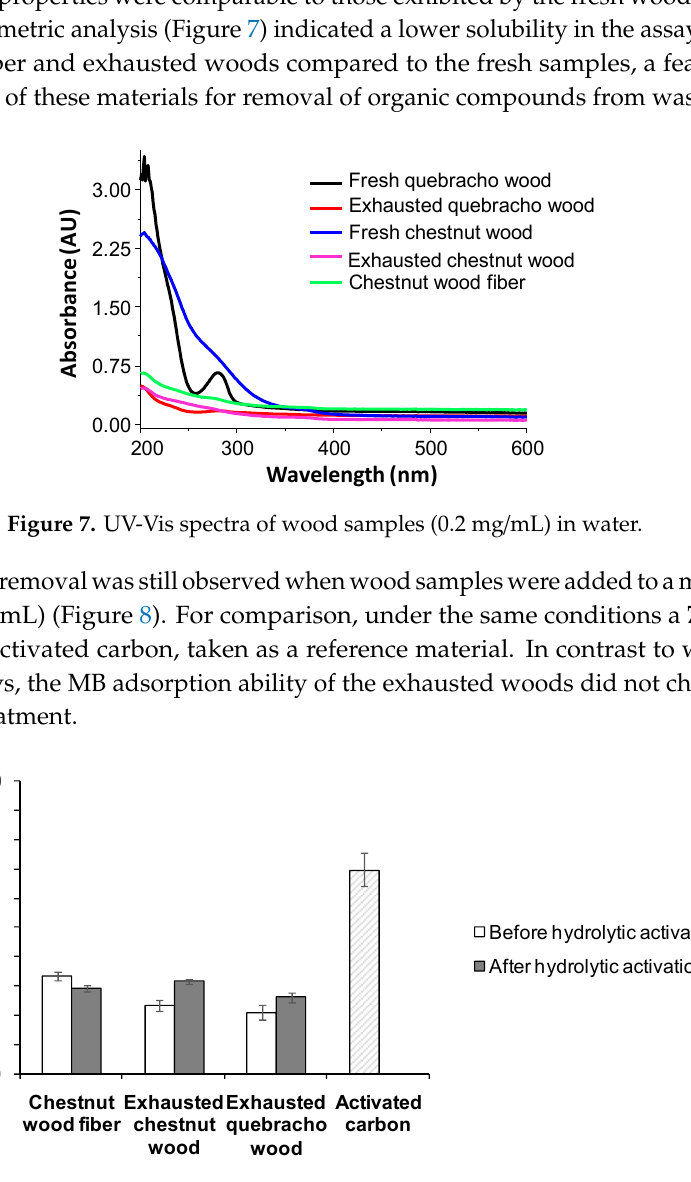
Figure 8. MB adsorption by chestnut wood fiber and exhausted woods before and after hydrolytic activation (MB starting concentration 25 mg/L). Reported are the mean ± SD values of at least three experiments. For comparison data relative to activated carbon are also reported.